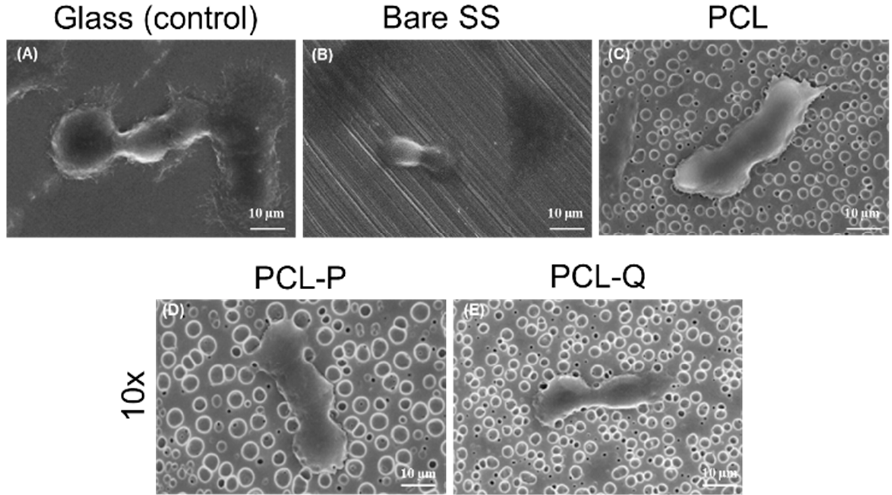
Figure 6. Characterization of the fibroblast colonizing the PCL coatings; SEM micrographs of fibroblasts colonizing the glass surface ( A ) that served as a positive control and of the plates, Bare SS ( B ); PCL ( C ); PCL-P10 ( D ) and PCL-Q10 ( E ) coatings.